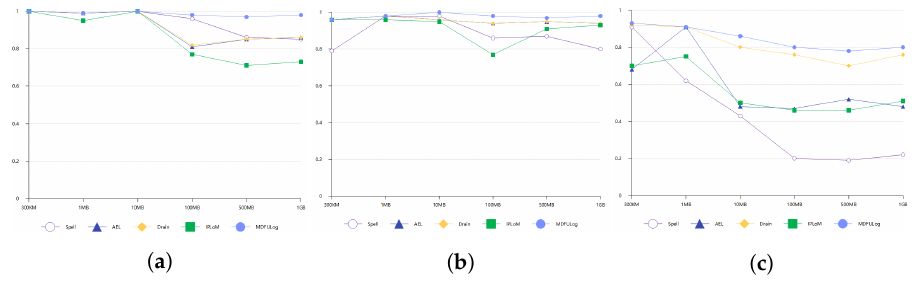
Figure 7. Accuracy of log parsing methods on various log volumes. ( a ) HDFS. ( b ) BGL. ( c )